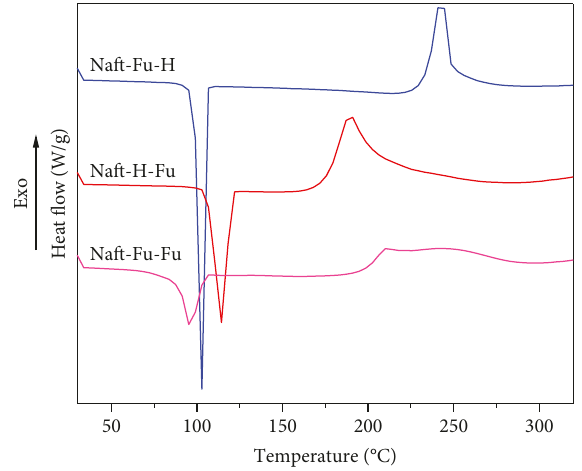
Figure 7: DSC thermograms of naphthoxazines containing furan groups.